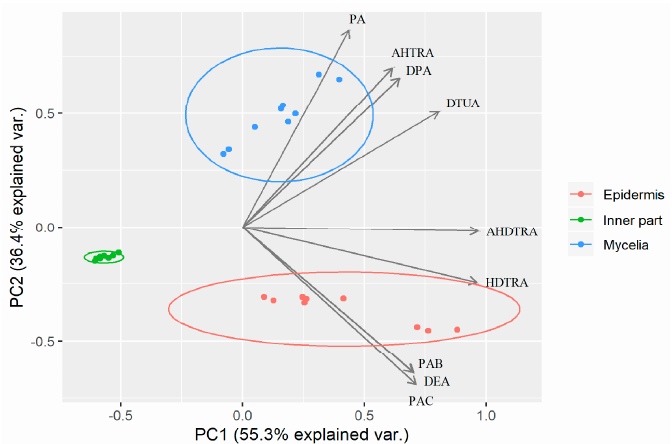
Figure 5. Biplot showing different samples of epidermis, inner part and mycelia of P. cocos on a two-dimensional space derived from principal component analysis (PCA) based on triterpene acids; the arrows indicate the projections of the original features onto the principal components.